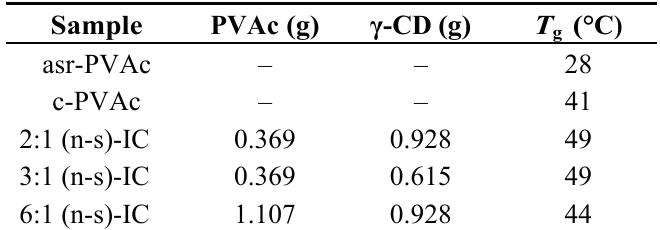
Table 2. T s of (n-s)-PVAc- γ -CD-ICs g